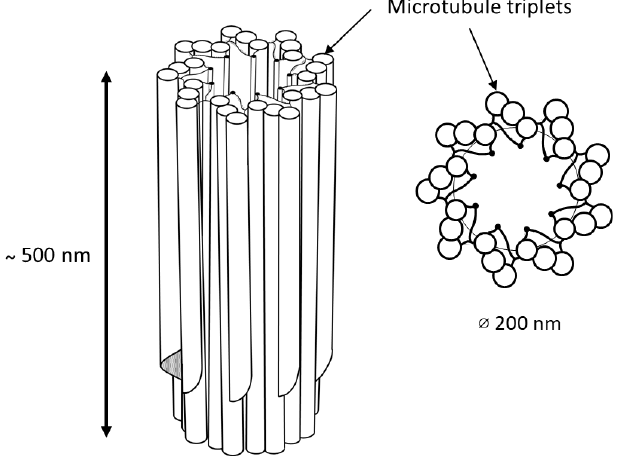
Figure 1. 9 triplets of microtubules to form a centriole.